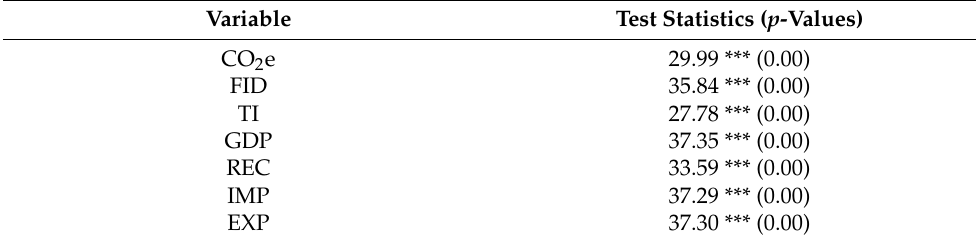
Table 3. Results obtained for CSD